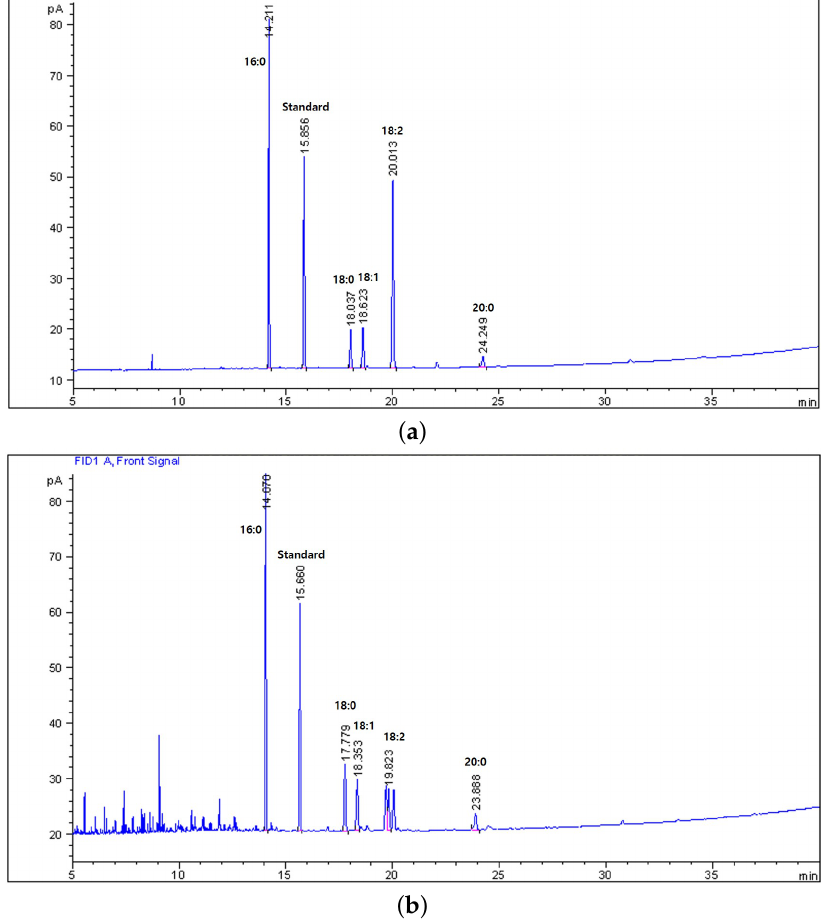
Figure 1. Fatty acid distributions of ( a ) spent coffee grounds and ( b ) coffee biocrude oil by GC